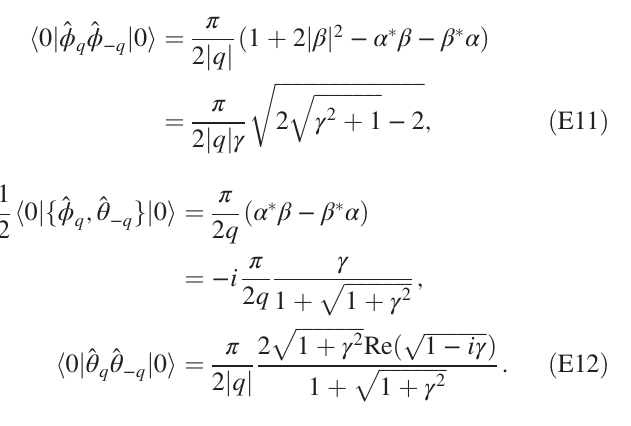
FIG. 6. Graphical representation of the reduced partition sum. Over the interval A , consecutive replicas are coupled. For the rest of the system R n A , replicas are decoupled from each other. The singular gauge A ð k Þ μ appears as charges of opposite sign at the boundaries of A